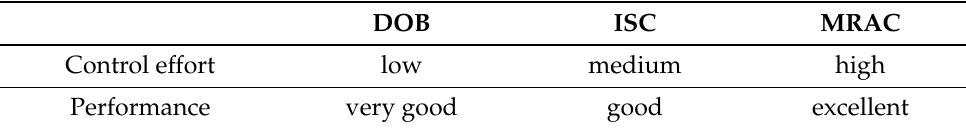
Table 1. Qualitative comparison between the controllers. DOB ISC MRAC Control effort low high very good